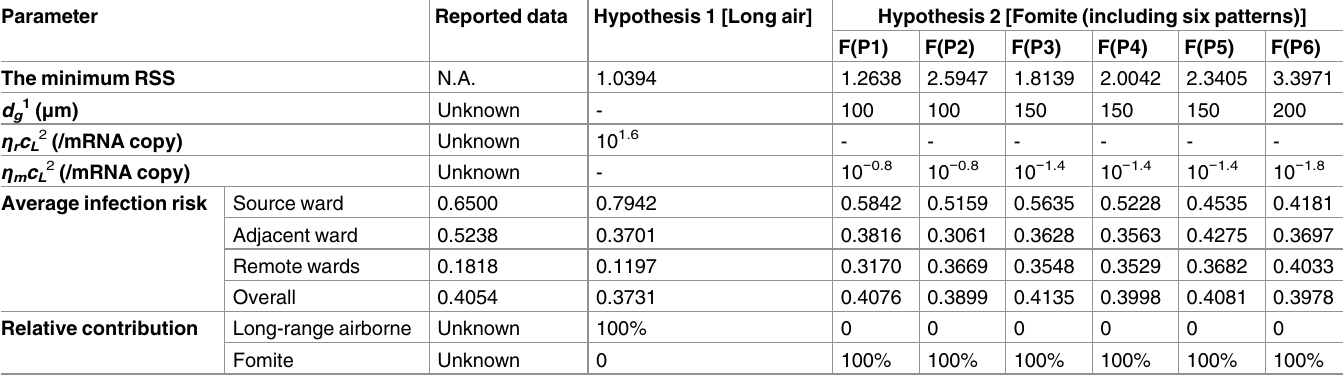
Table 1. Important parameters for scenarios with the minimum RSS for Hypotheses 1 [Long air] and 2 [Fomite (including six patterns)].